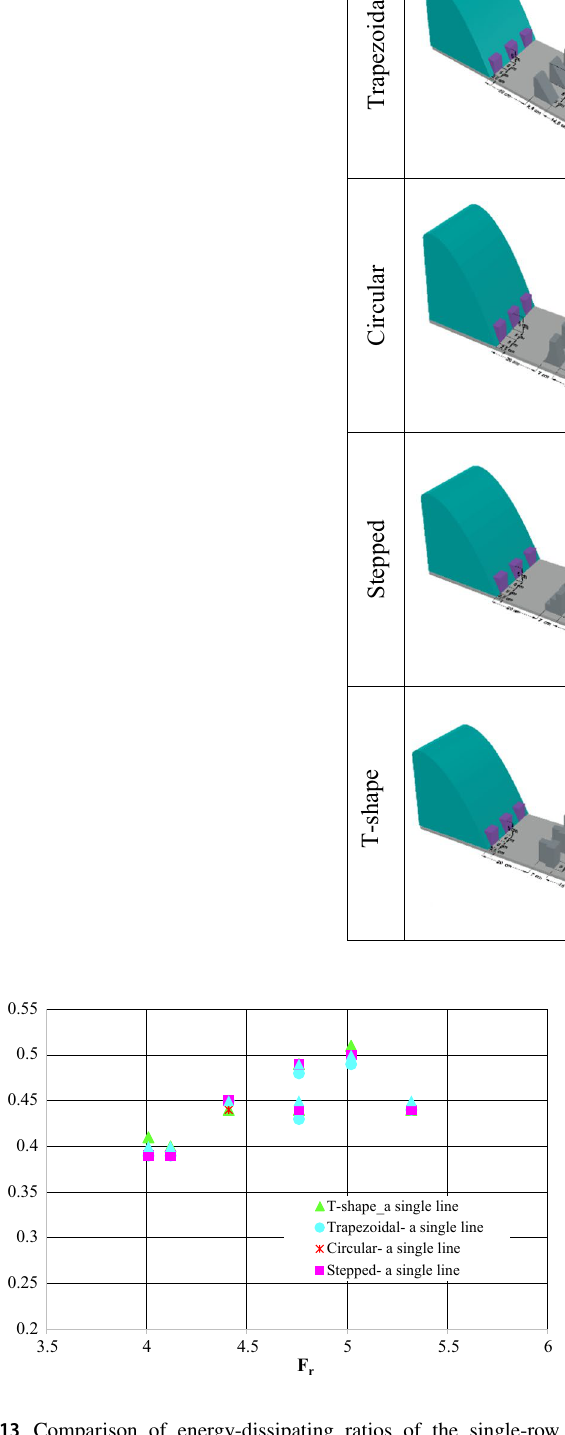
Fig. 13 Comparison of energy-dissipating ratios of the single-row energy dissipaters